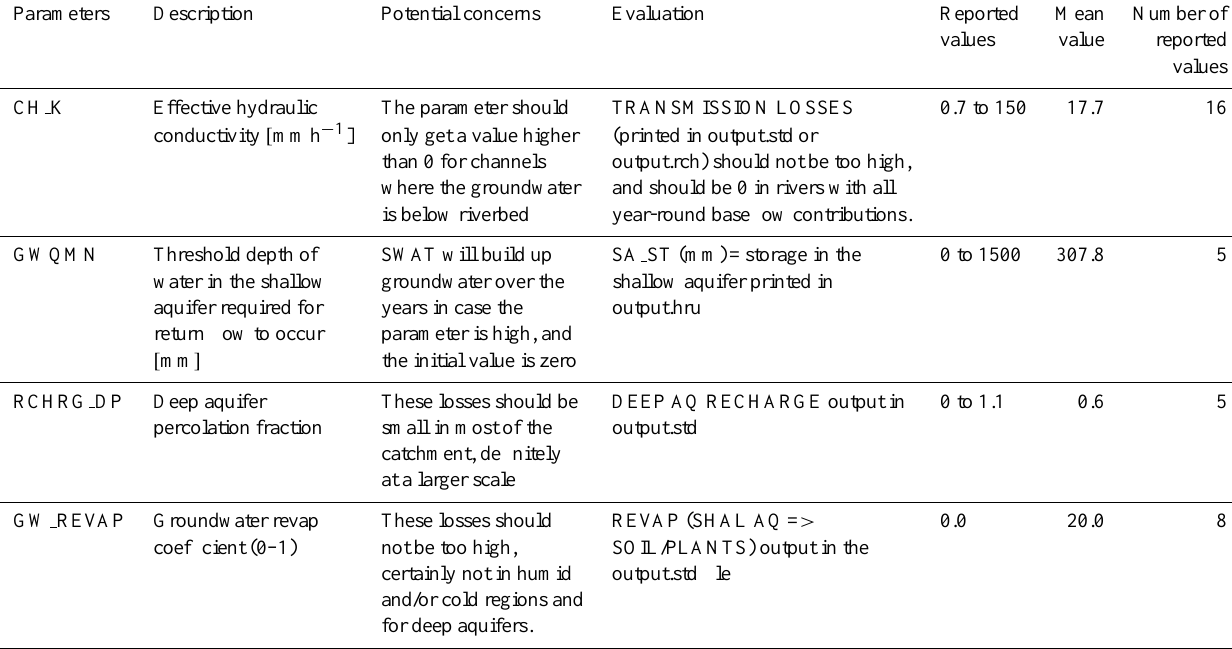
Table 2. Parameters that are controlling losses (in addition to